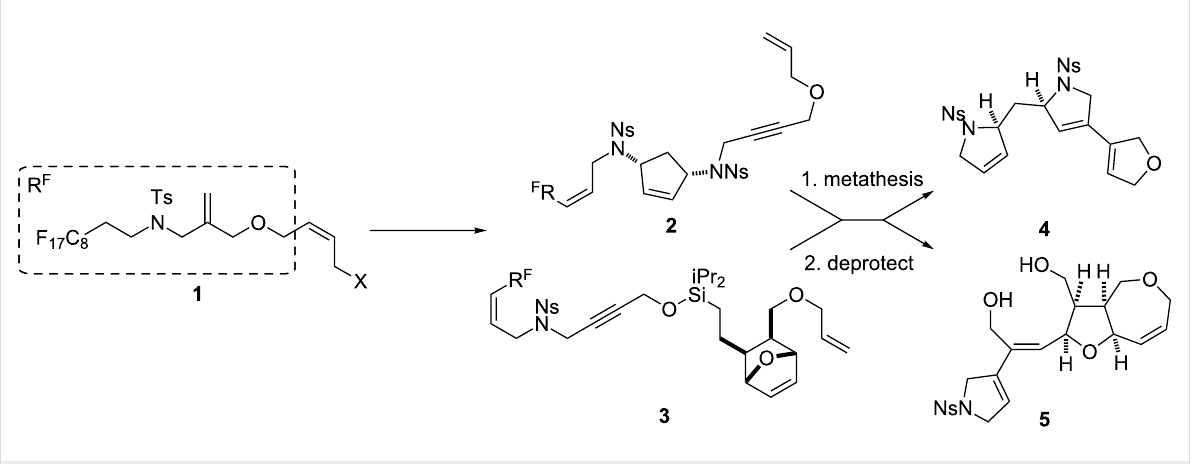
iterative attachment of simple unsaturated building blocks to a fluorous-tagged linker 1 (e.g., → 2 or 3 ). Subsequently,